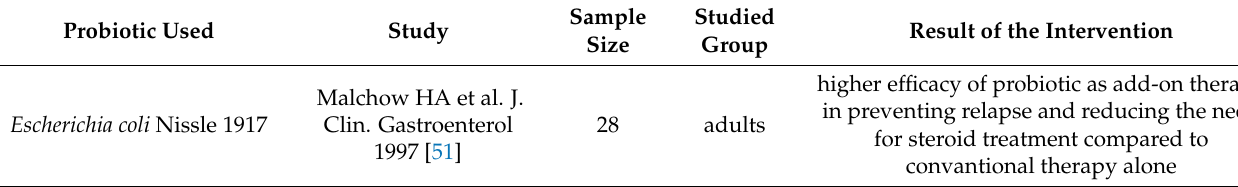
Table 2. Results of clinical studies of using probiotics in Crohn’s disease